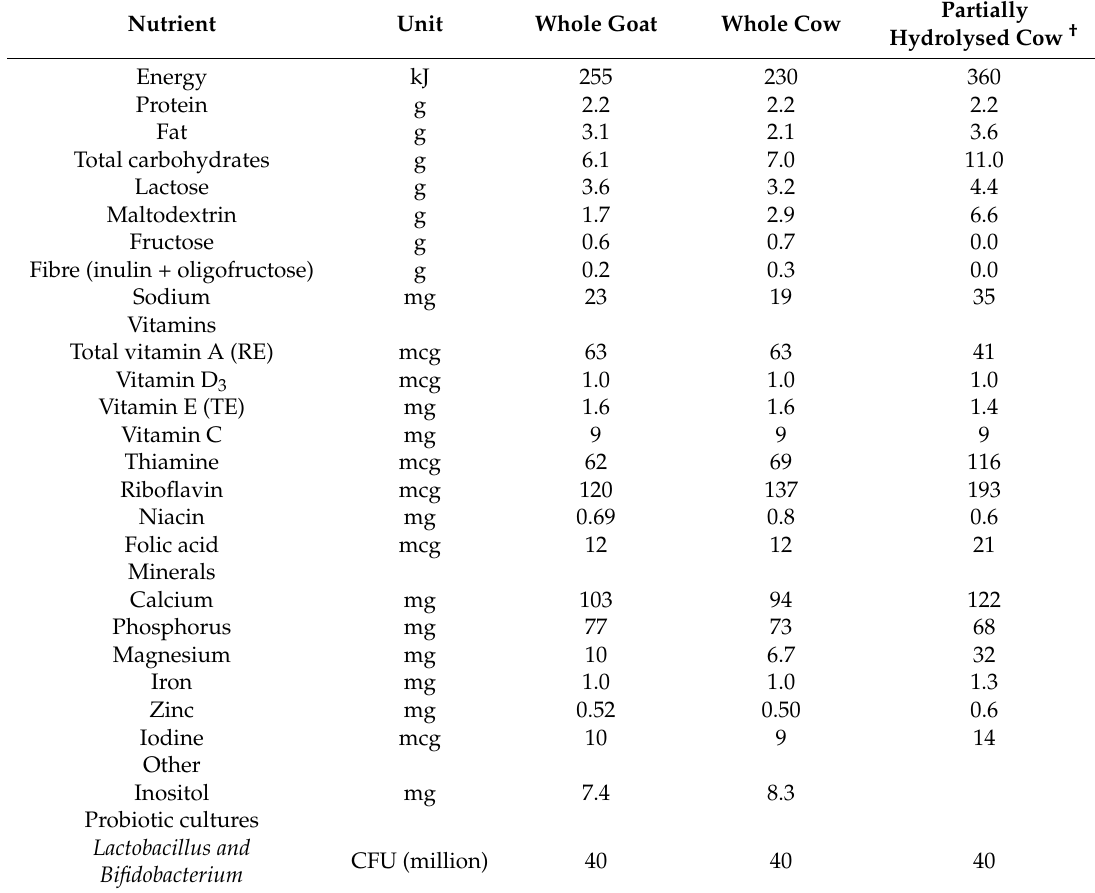
Table 1. Nutritional composition per 100 mL prepared fortified